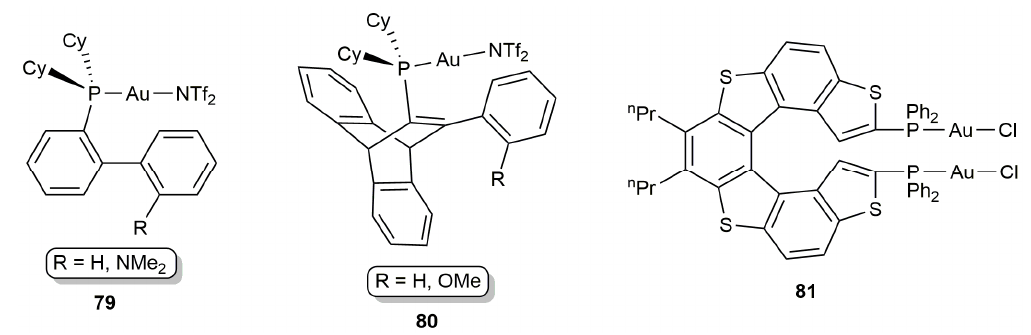
Figure 9. Structure of the gold(I)-phosphine complexes 79-81 .